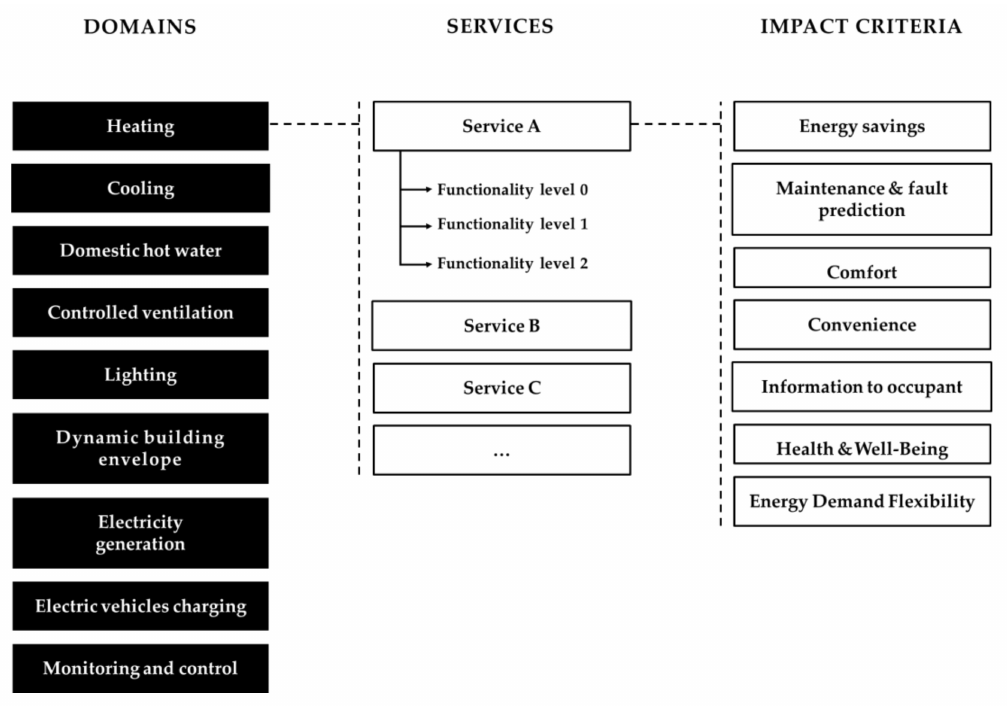
Figure 1. Structure of the Smart Readiness Indicator (SRI) service catalogue